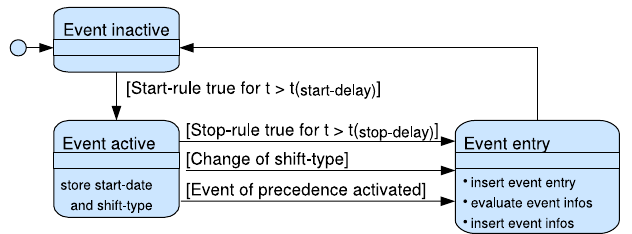
FIG. 2. (Color) Generic state diagram for each automatic event type defined by an event rule set.